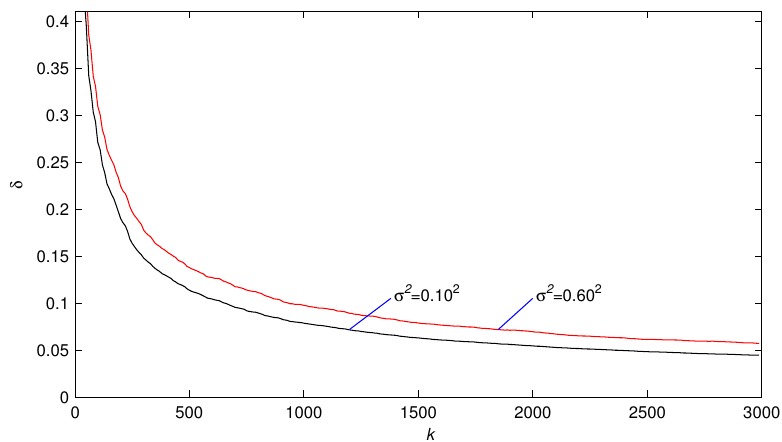
Figure 5. The F-M-ML-MIESG estimation errors versus k with different σ 2 ( p =